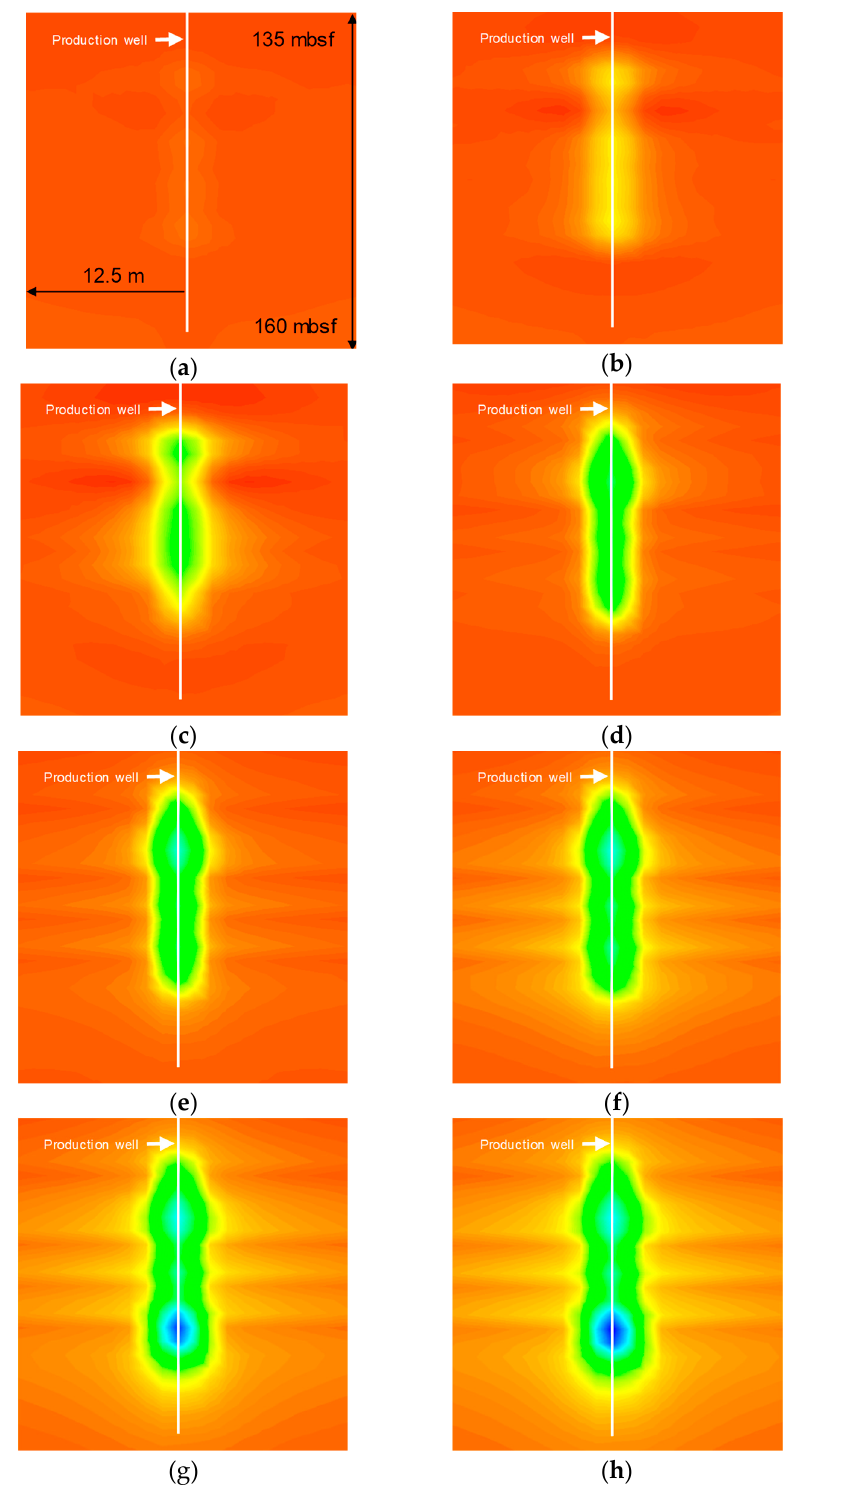
Figure 11. Distribution of confining stress with production period: ( a ) after 1 hour; ( b ) after 6 hours; ( c ) after 12 hours; ( d ) after 1 day; ( e ) after 7 days; ( f ) after 14 days; ( g ) after 21 days; ( h ) after 30 days.